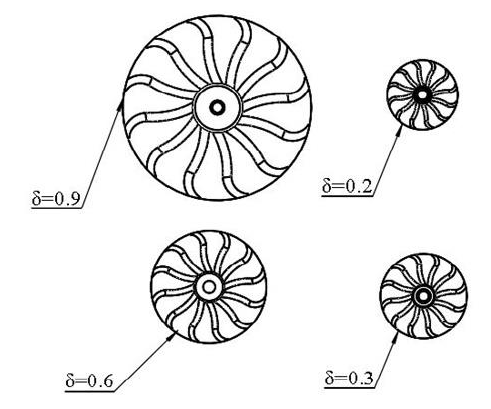
Figure 2. Impeller of the vortex of the absorber.